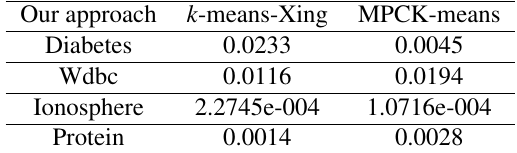
Table 7. t -test on the four difficult datasets with all trial results Our